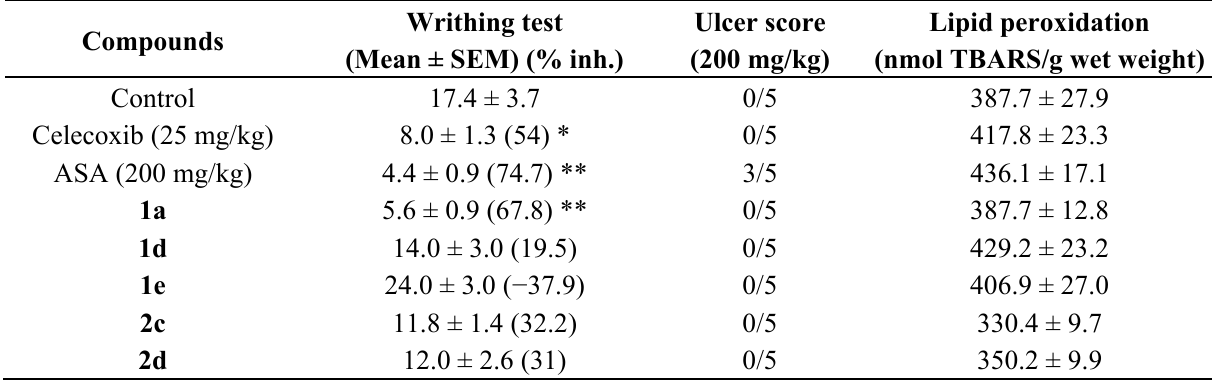
Table 2. Analgesic effects of the test compounds at a 100 mg/kg dose, against acetic acid-induced abdominal constriction test, ulcer score and the lipid peroxidation levels in stomach of